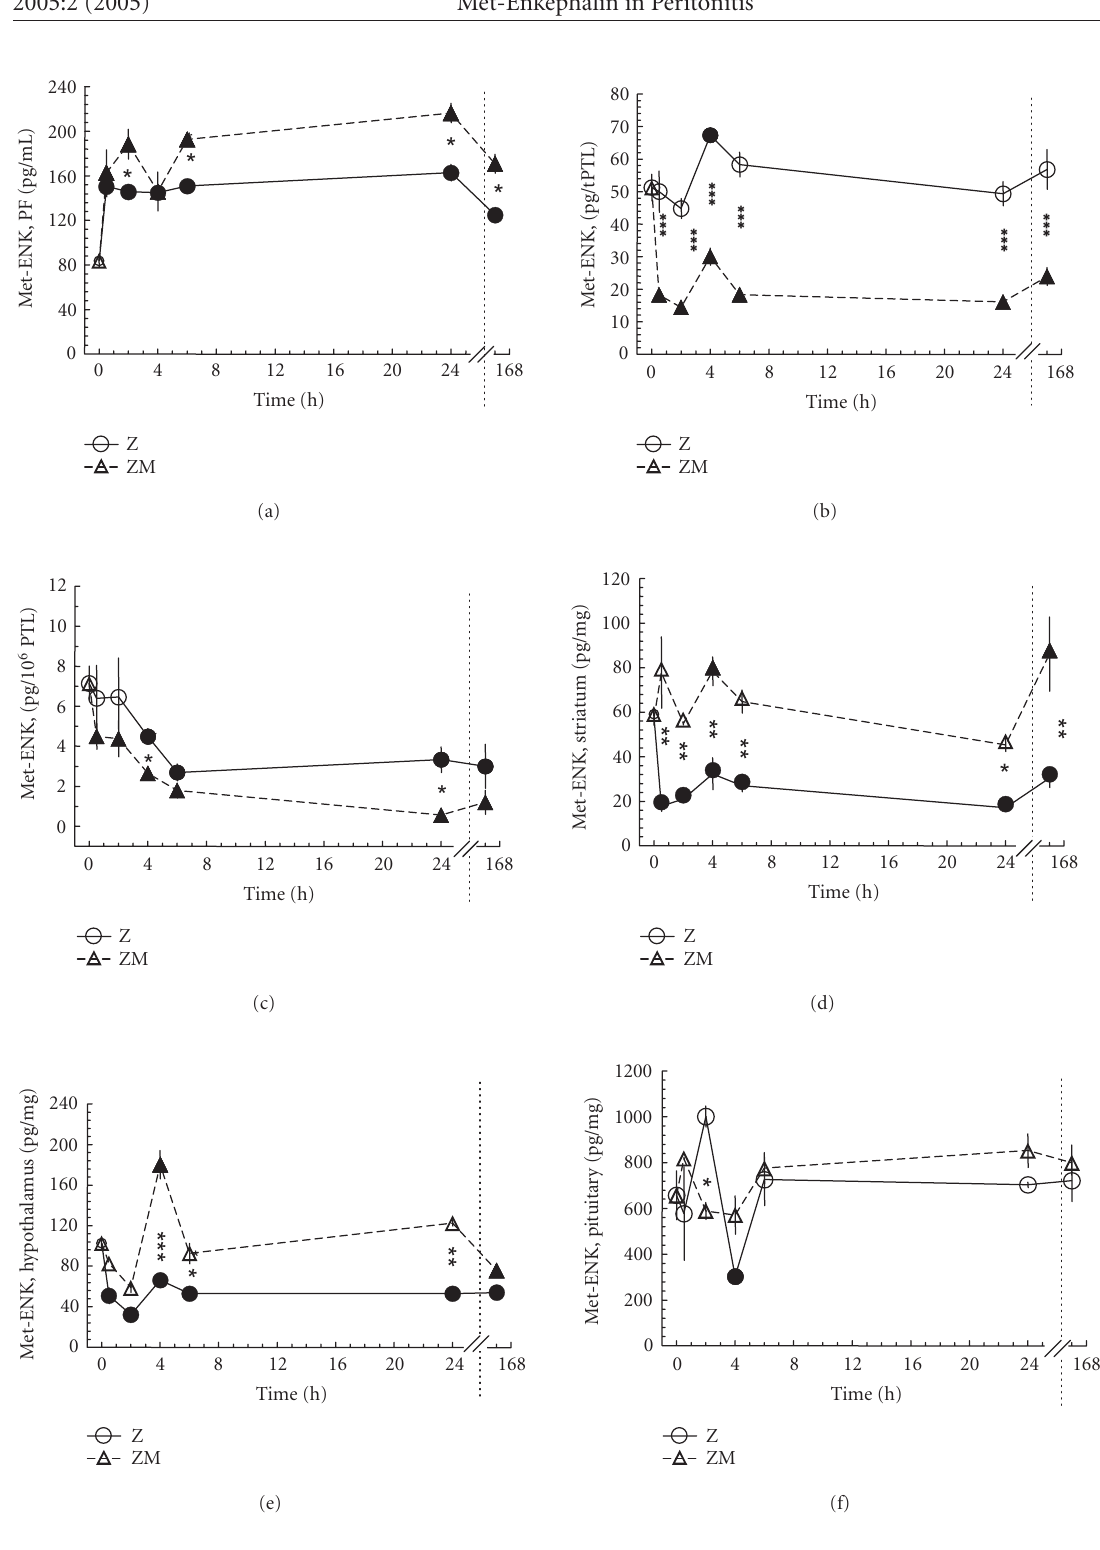
Figure 2. Time course of Met-enkephalin levels in males of Swiss mice either intact (time 0) or IP injected with zymosan (Z, solid lines and circles) or zymosan with morphine (ZM, broken lines and triangles) in (a) peritoneal fluid (PF); (b) total pool of PTLs; (c) 10 6 PTLs; (d) striatum; (e) hypothalamus; (f) pituitary gland. The results are expressed as X + SE, n = 4–8. Solid symbols indicate means significantly di ff erent from time 0 according to ANOVA at P < . 05; asterisks between significantly di ff erent means of Z and ZM groups at the given time point according to post hoc Tukey’s test denote that P < . 05 ( ∗ ); P < . 01 ( ∗∗ ); P < . 001 ( ∗∗∗